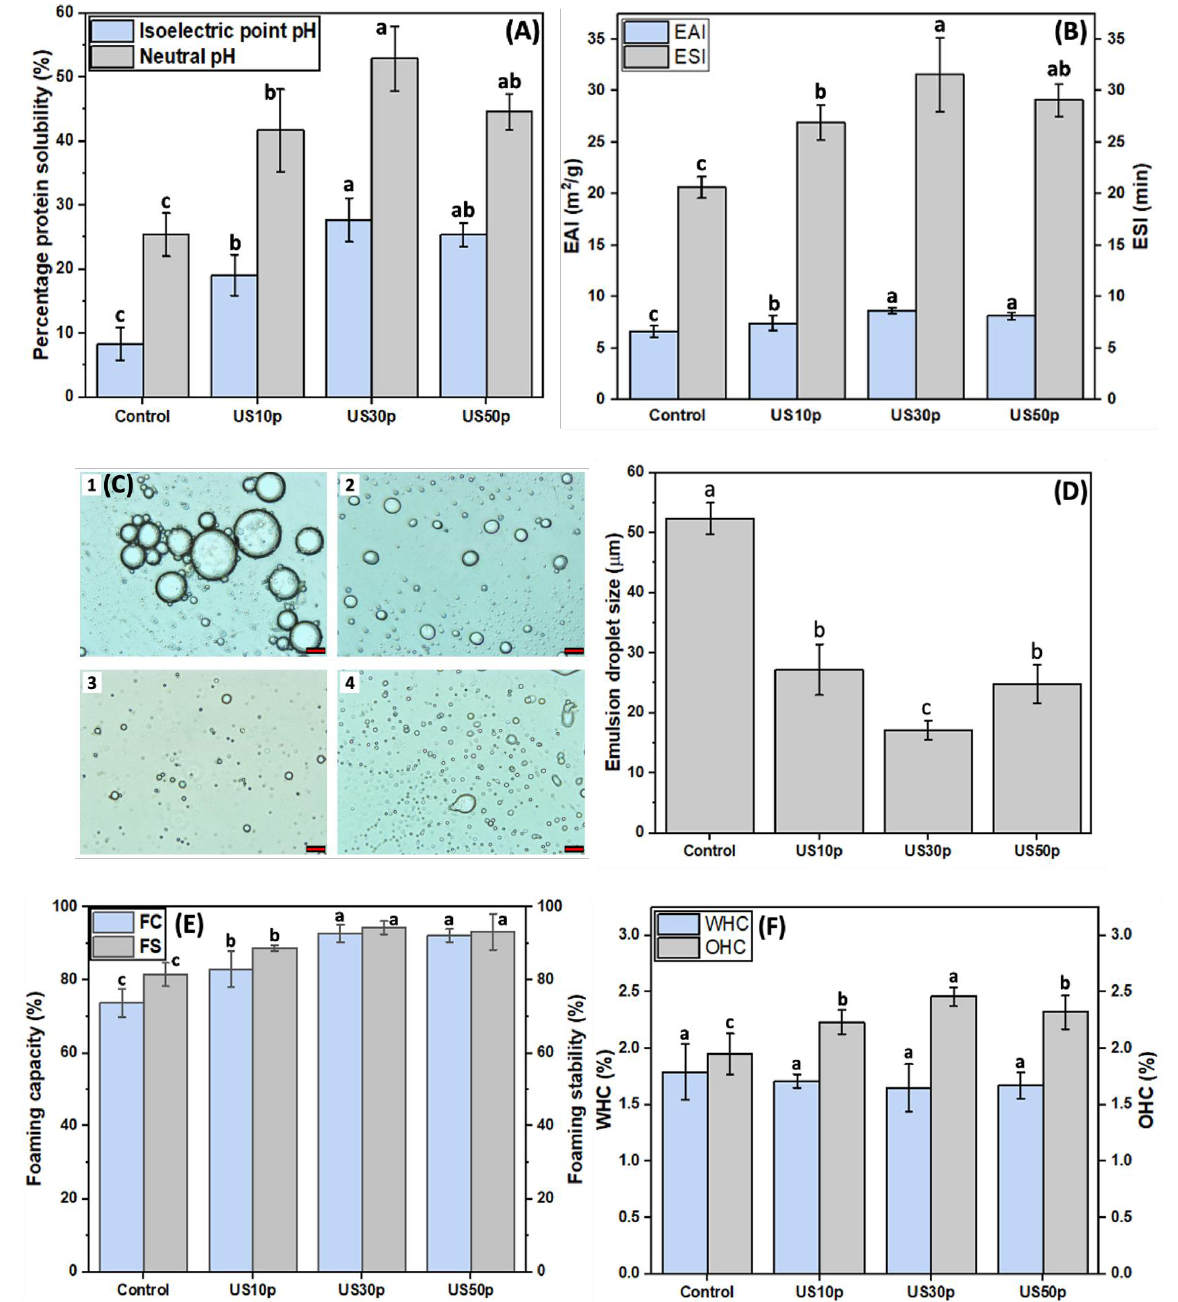
Figure 3. ( A ) Percentage protein solubility of untreated HPI and HPI extracted with the US-assisted method (under 11.2, 26.8, and 50.0 W/cm 2 for 5 min) at pH 5.0 and 7.0; ( B ) Emulsifying ability index (EAI) and emulsifying stability index (ESI) of conventionally extracted HPI and HPI extracted with the US-assisted method (under 11.2, 26.8, and 50.0 W/cm 2 for 5 min) at pH 7.0; ( C ) The microstruc- tures of (1) Conventionally extracted HPI, (2) US10p-HPI, (3) US30p-HPI, and (4) US50p-HPI-stabi- lized emulsions, the scale bar in the OM is 20 μm ; ( D ) The hempseed protein-stabilized emulsion droplet size; ( E ) The effect of high-intensity ultrasound extraction (11.2, 26.8, and 50.0 W/cm 2 for 5 min) on foaming properties of HPI; ( F ) The impact of high-intensity ultrasound extraction (11.2,